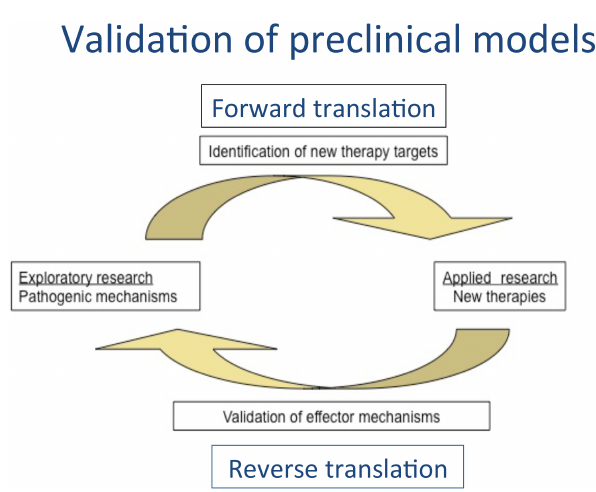
Figure 4. Validation of the marmoset experimental autoimmune en- cephalomyelitis (EAE) model. Therapies showing promising clini- cal effects in the EAE model, of mouse and marmosets alike, are tested in MS patients. When this forward translation proves suc- cessful, it confirms the validity of the targeted pathogenic process EAE model for MS. In the case of forward translation showing that promising clinical effects observed in MS cannot be reproduced in MS, the treatment should be re-evaluated in the EAE model to ex- amine why the targeted process seems irrelevant for